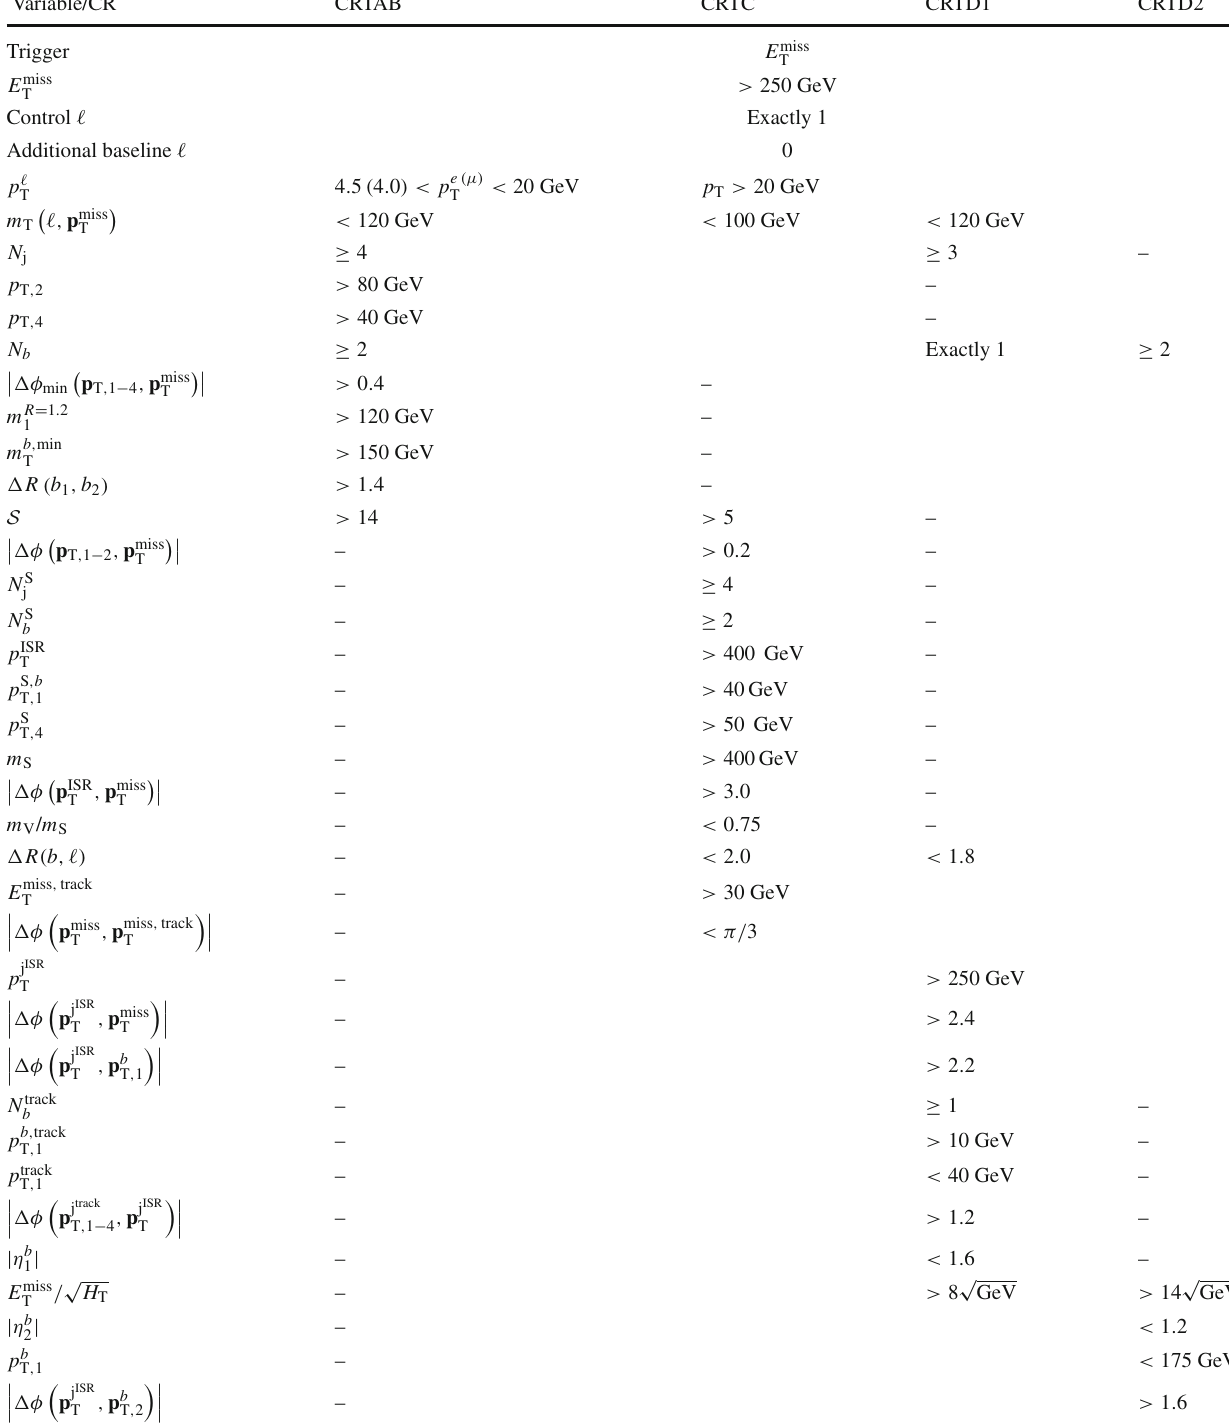
Table 7 Selection criteria for the t ¯ t control regions. The defining extrapolation for these control regions is over the number of leptons; one electron or muon ( (cid:13) ) from W decays is required, compared with zero leptons in the signal region. A dash indicates that no selection is applied. Variables for which the signal and control region requirements